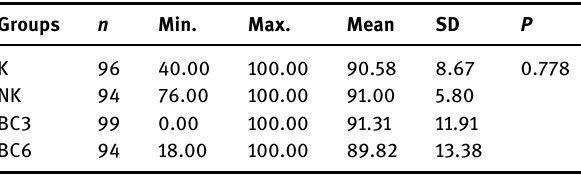
Table 5: Comparison of groups in terms of chick